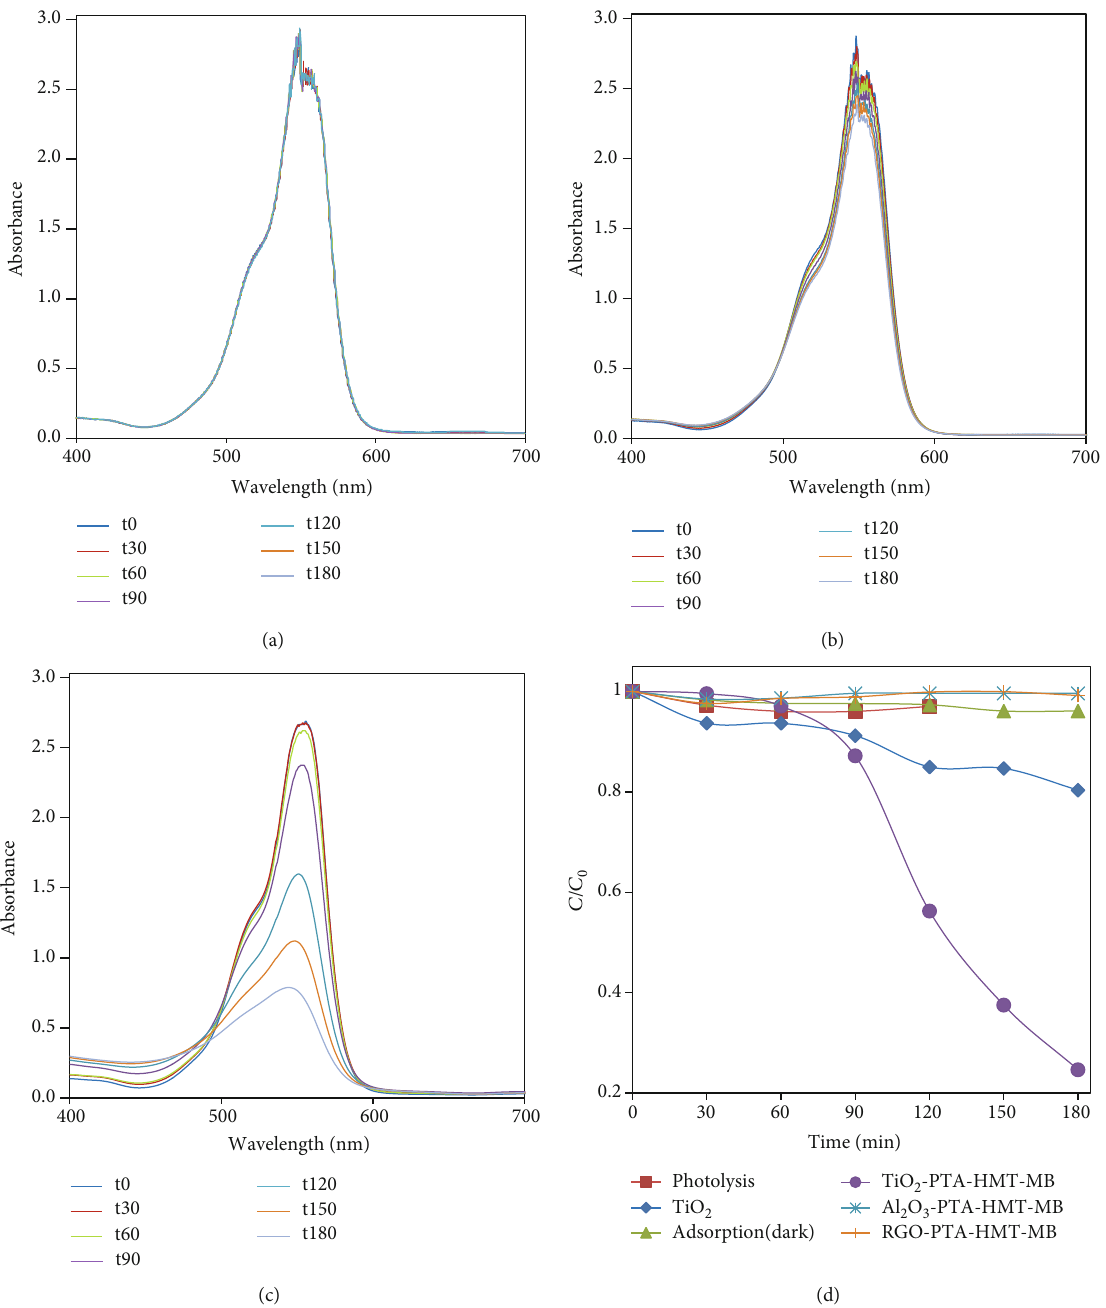
Figure 4: UV-Vis absorption spectra of RhB (15 mg/L, 100mL, pH = 9 : 0 ) during the photodegradation under sunlight without photocatalyst (photolysis) (a), in the presence of TiO